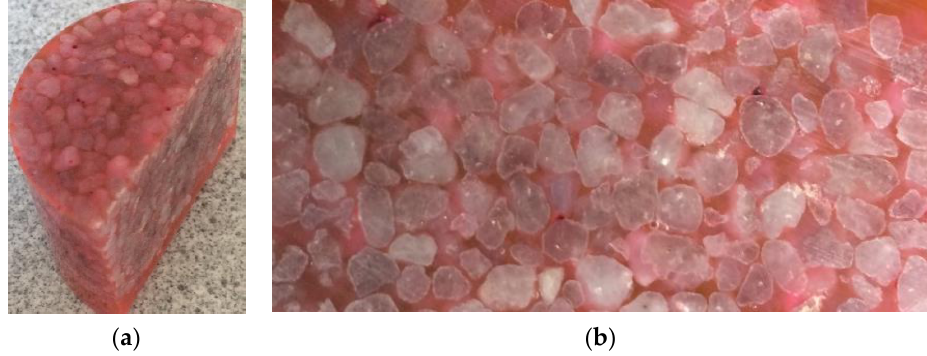
Figure 2. ( a ) Picture of the sand packing in 3D; ( b ) Picture of the 2D cut-section of the sand packing assembly.